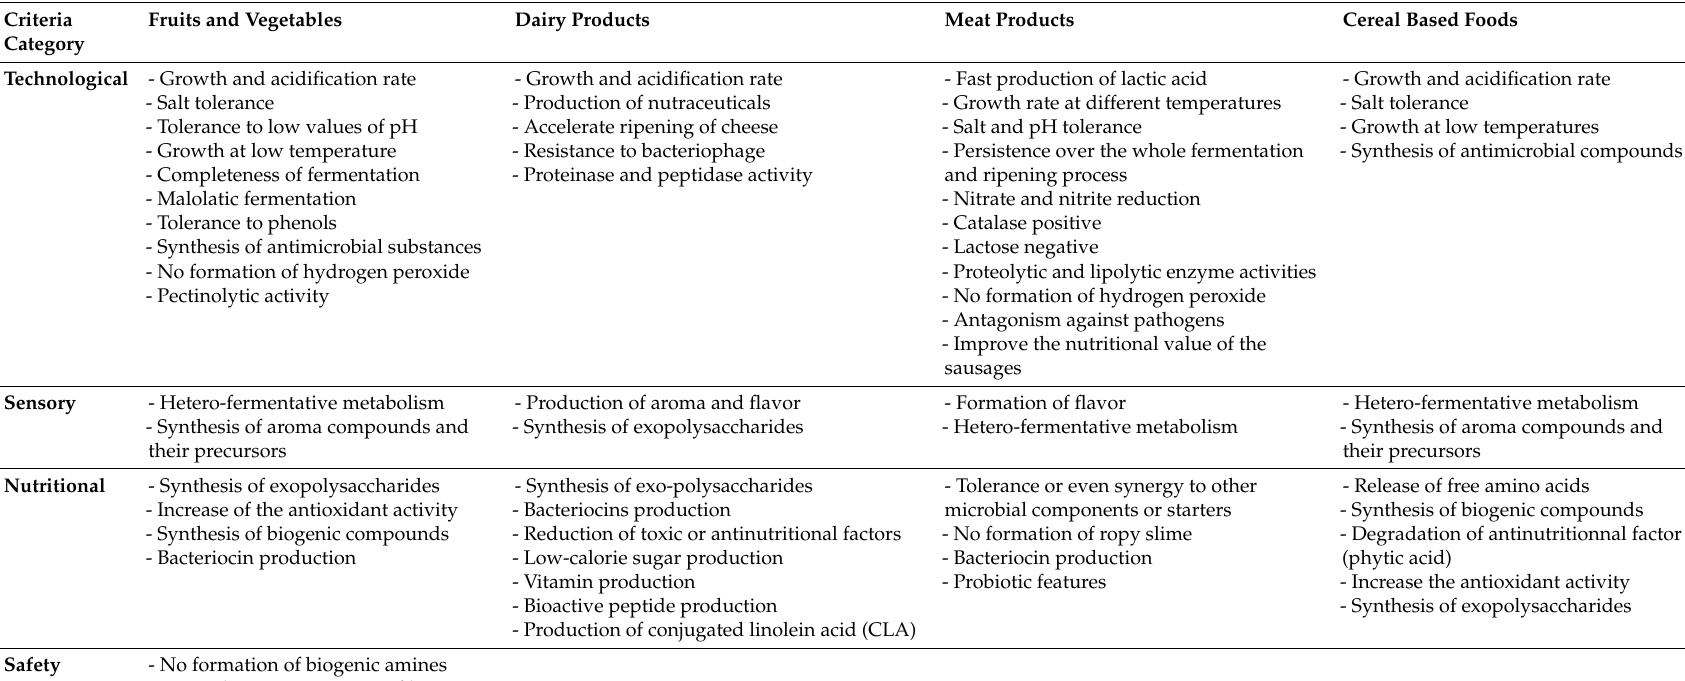
Table 4. Criteria for the selection of starters for fruits and vegetables, cereal, dairy and meat